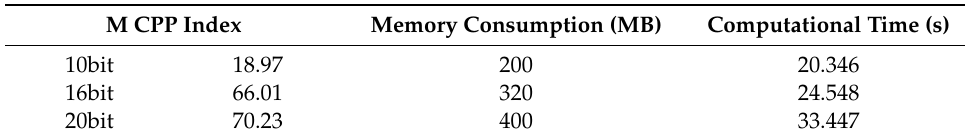
Table 3. Comparison of the Contrast-Per-Pixel (CPP) Index and Computational Time with Di ff erent Grayscale